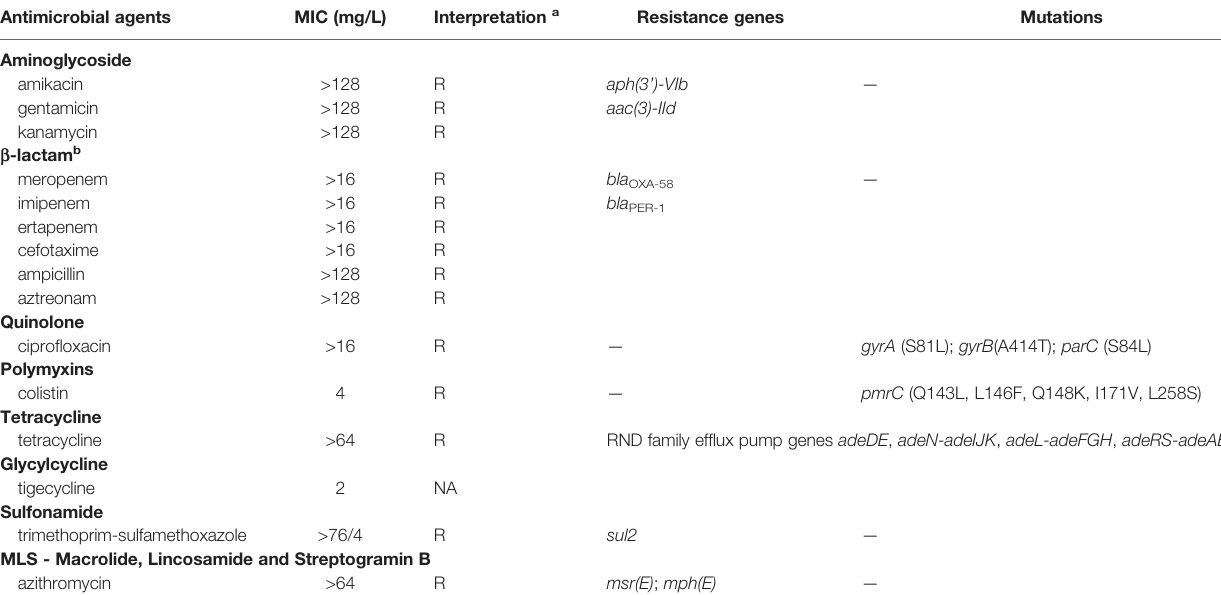
TABLE 1 | Results of antimicrobial susceptibility tests and genetic characterization. Antimicrobial